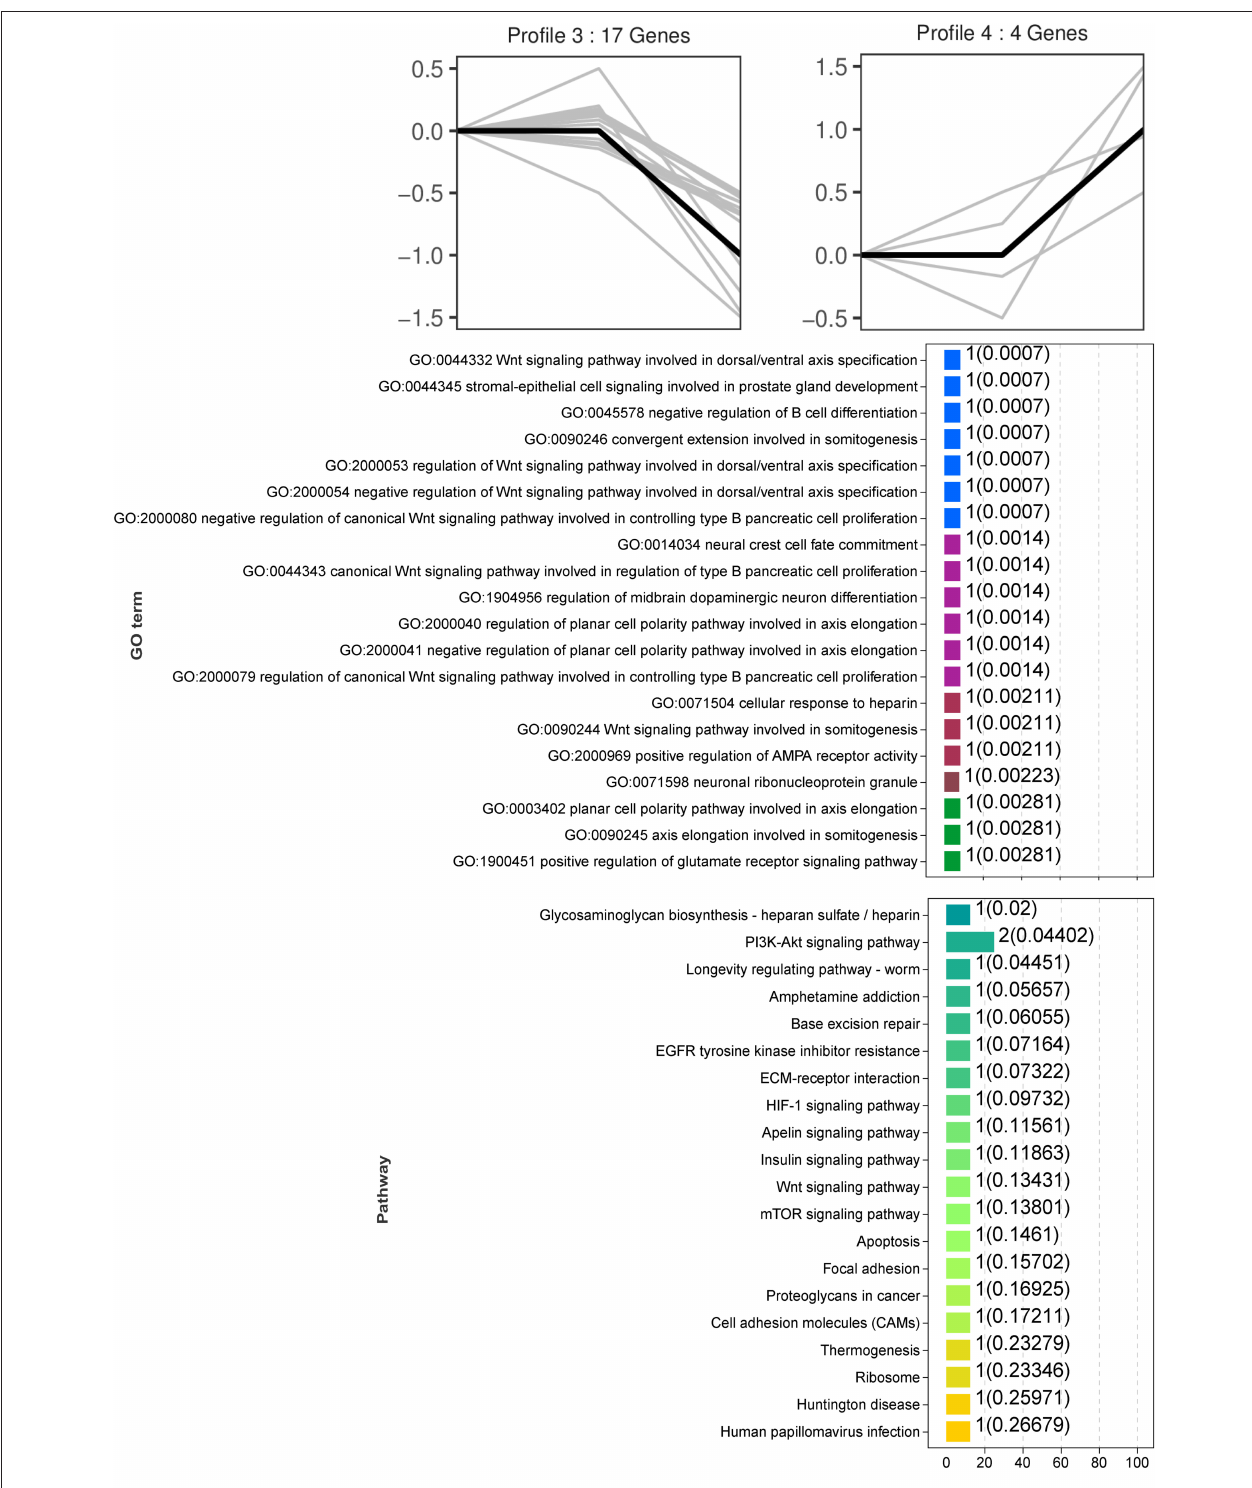
FIGURE 6 | GO and KEGG enrichment analysis of DEGs (in profile 3 and profile 4) with the HC response at BHBA-2.4 m M concentration.